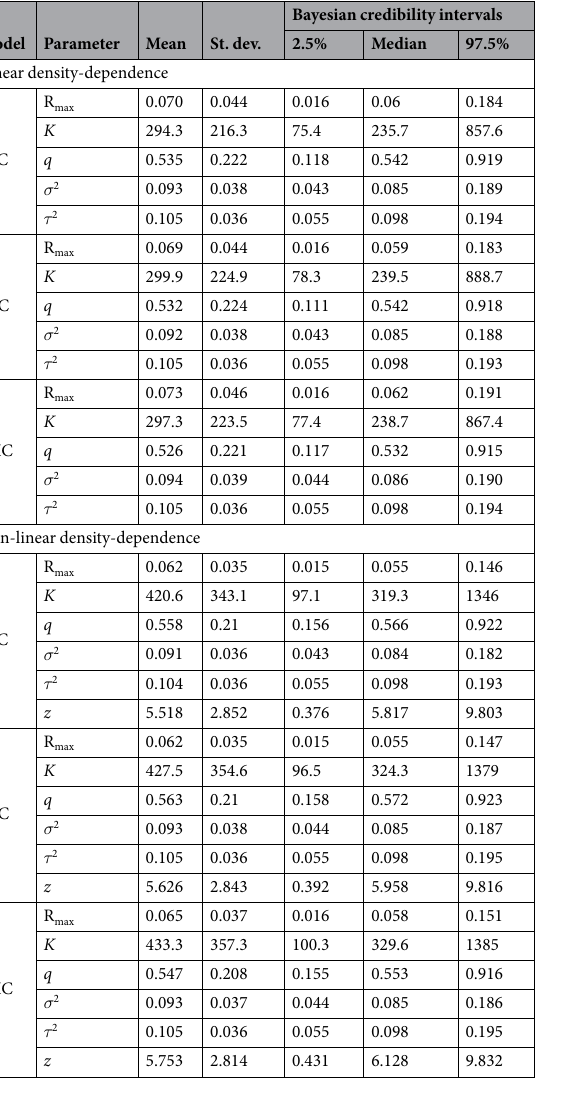
Table 1. Parameter estimates (posterior mean, standard deviations and credibility intervals) for maximum rate of increase (R max ), carrying capacity ( K , expressed in thousands of individuals), detectability coefficient ( q ), process variance ( σ 2 ), observation variance ( τ 2 ) and shape parameter ( z ) derived from the six Bayesian state- space surplus production models (linear and non-linear density-dependence models under the three bycatch indices). TC: Total Catch set; AC: Average Catch set; MC: Maximum Catch